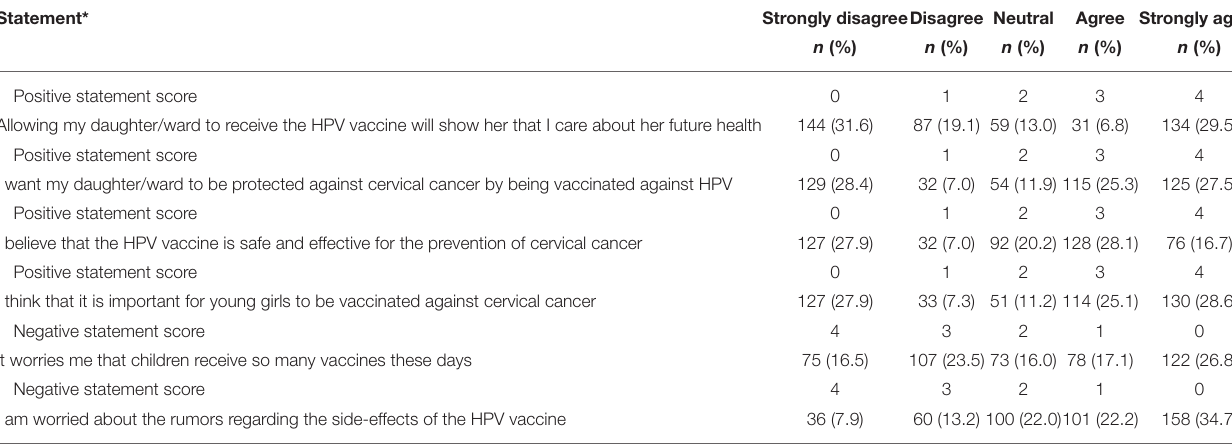
TABLE 5 | Caregivers’ attitudes toward HPV vaccination ( n = 455).